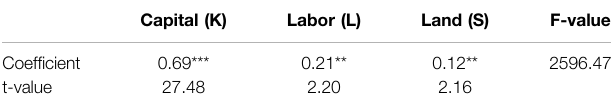
TABLE 1 | Parameter estimation results of Shandong province ’ s production